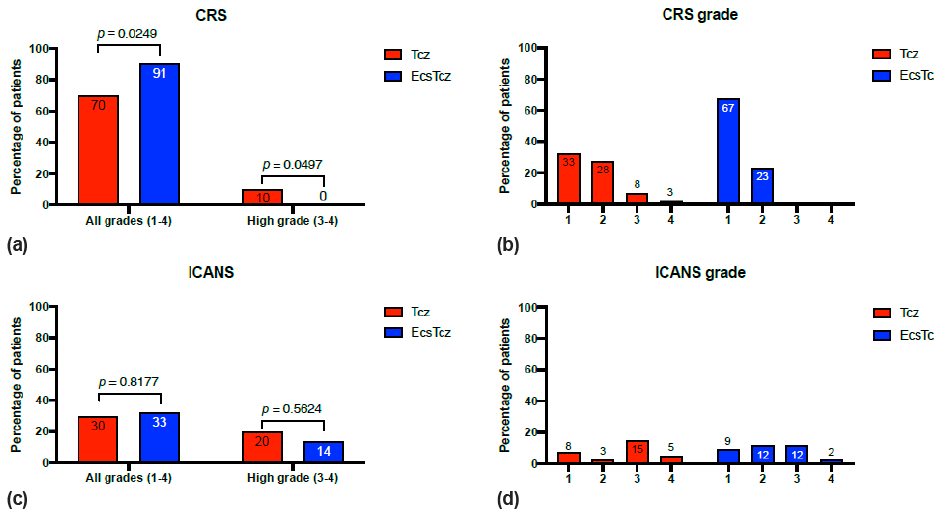
Figure 2. Comparison of adverse events from CAR T-cell therapy in cohorts Tcz vs. EcsTcz. ( a ) Com- parison of CRS incidence. ( b ) Visualization of CRS grade distribution. ( c ) Comparison of ICANS incidence. ( d ) Visualization of ICANS grade distribution. Table 4. Correlation of multiple predictors with the incidence of CRS and ICANS during CAR T-cell